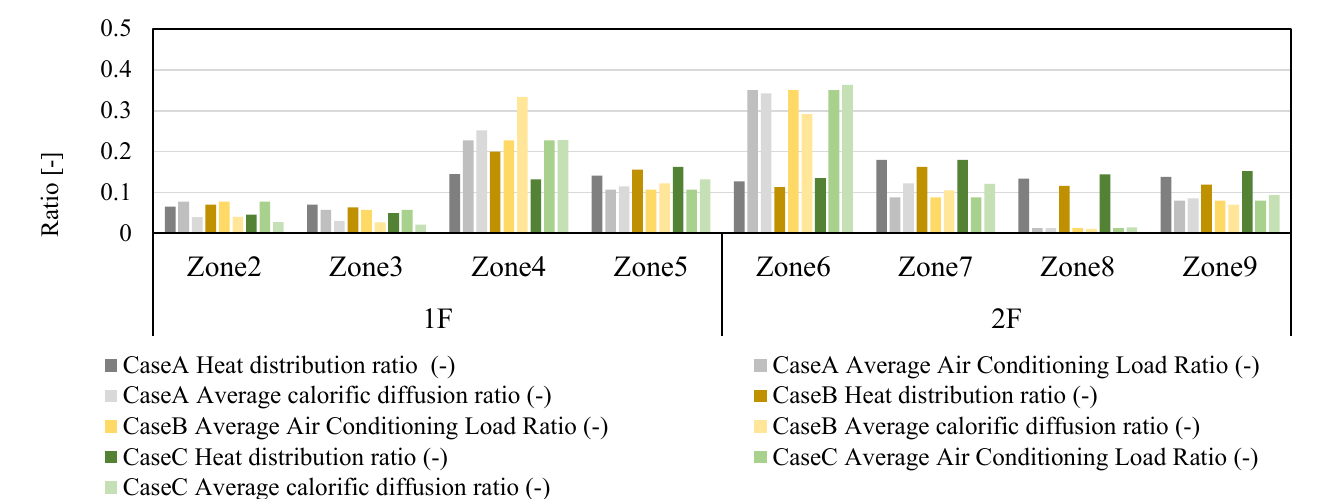
Figure 9. Inter-case comparison of heat distribution ratios in winter.